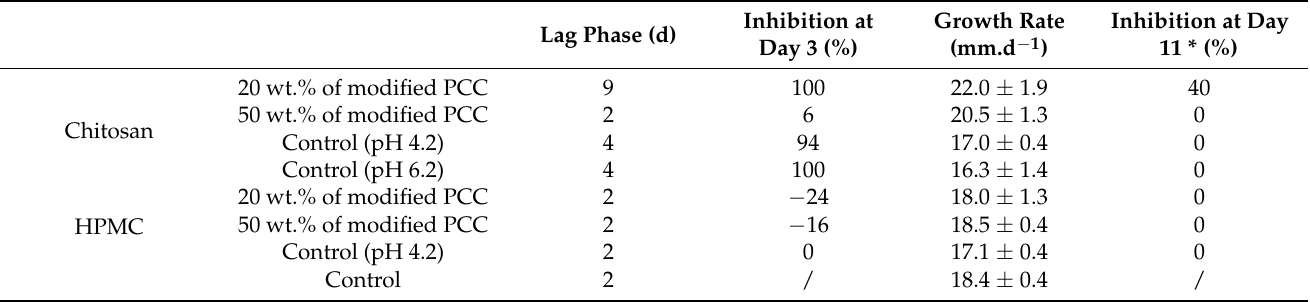
Table 7. Antifungal activity of film-forming solutions on C. globosum (20 spores inoculated) at days 3 and 11. Inhibition percentages were given as control